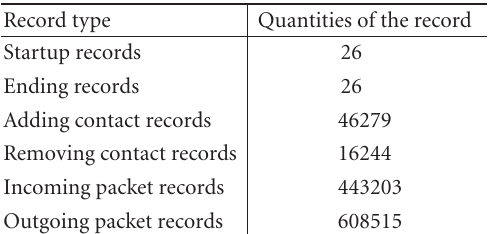
Table 1: Number of